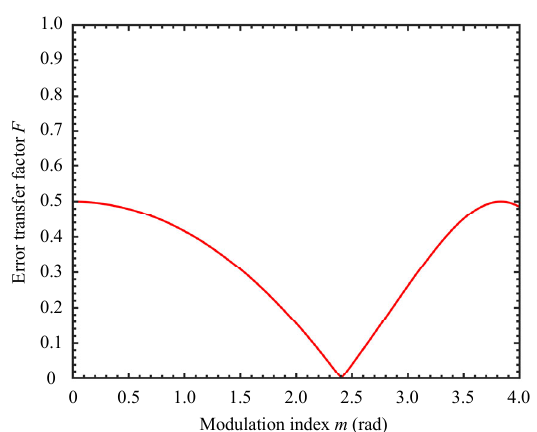
Fig. 6 Error transfer